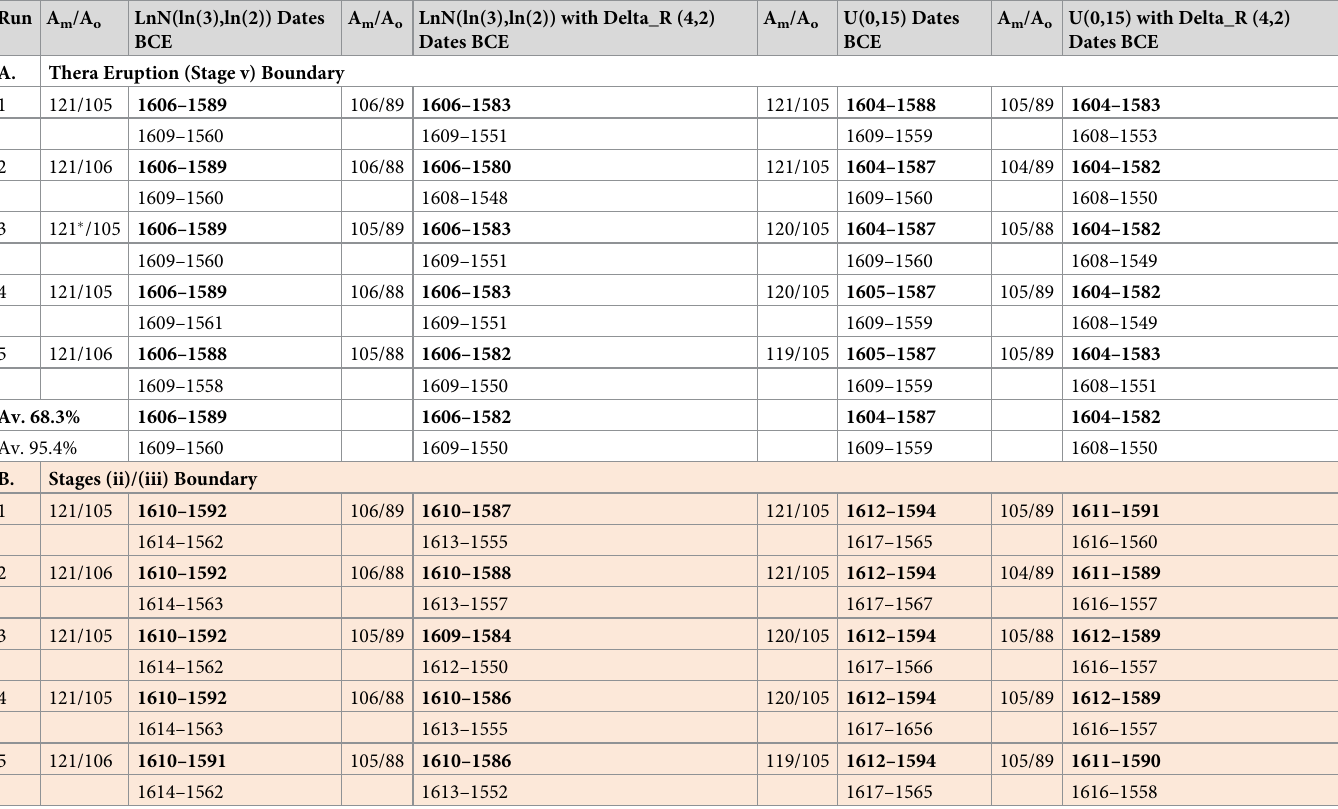
Table 1. Model 1 (Fig 9) results. A. Results ( bold = 68.3% hpd , and non-bold = 95.4% hpd) for the date of the Thera Eruption Boundary from 5 runs of Model 1 (Fig 9) with the Difference query with LnN(ln(3),ln(2)) constraint † , and from 5 runs of an alternative version using a Difference query with U(0,15) constraint, each without,